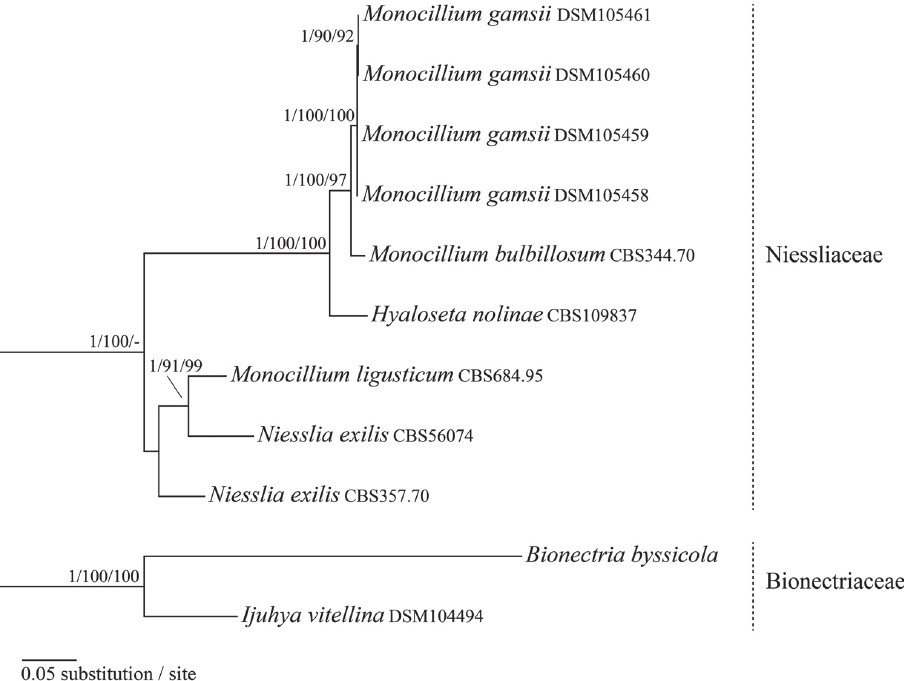
Figure 2. Bayesian inference of phylogenetic relationships using four strains of the here described nema- tode parasite and all Niessliaceae present in GenBank based on an alignment of ITS, LSU, rpb1 , and tef sequences using GTR+I+G as nucleotide substitution model. Depicted is a 50% majority rule consensus tree derived from 3500 trees from the stationary phase of a Monte Carlo Markov Chain. A posteriori probability (BIpp) values greater than 0.95, and bootstrap values of neighbor-joining (NJBT) and maxi- mum likelihood (MLBT) analyses greater than 0.7 are given above branches (BIpp/NJBT/MLBT). Two representatives of the Bionectriaceae, Bionectria byssicola and Ijuhya vitellina , were used to root the